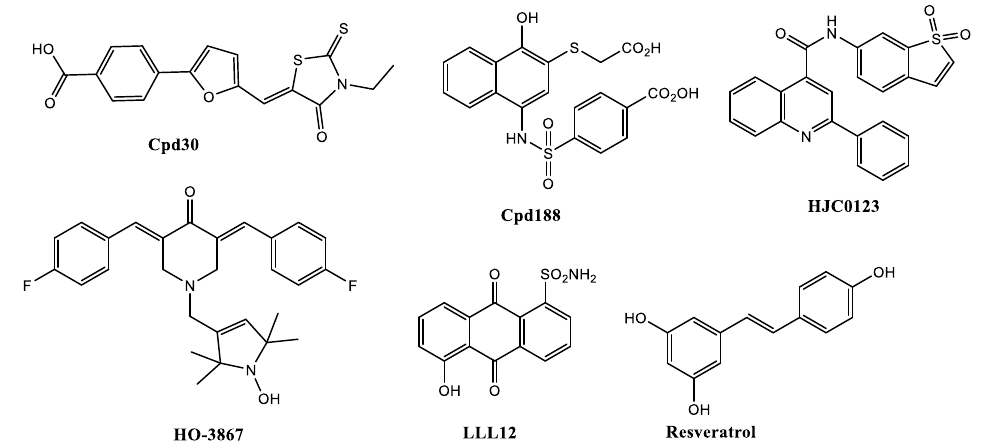
Figure 5. Some inhibitors of STAT3 activity with no carbazole structure.